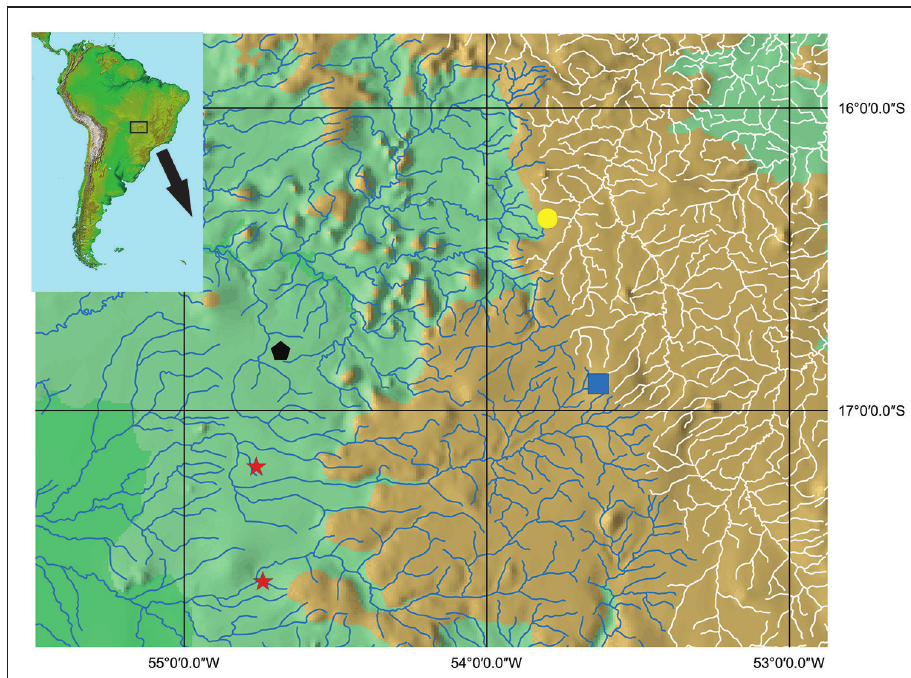
Figure 3. Geographical distribution of killifishes of the Melanorivulus dapazi species group. Yellow circle: M. ignescens ; black pentagon: M. flavipinnis ; blue square: M. regularis ; red star: M. dapazi . Blue river drainage: Paraguai; white river drainage: